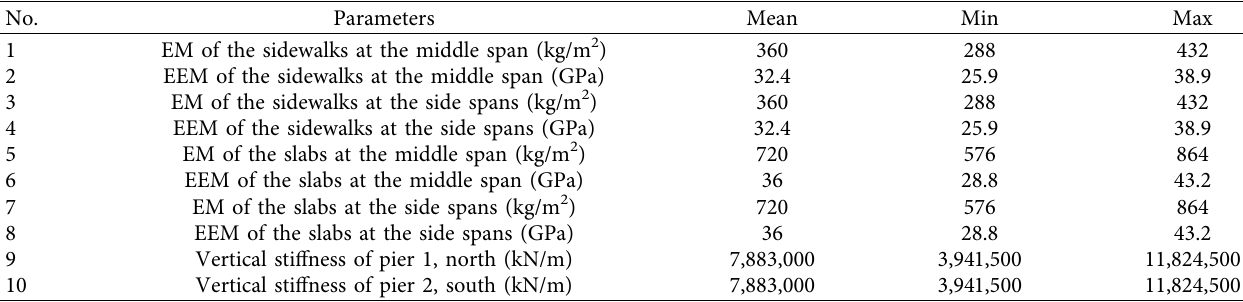
Table 2: List of the parameters considered for the FE model updating